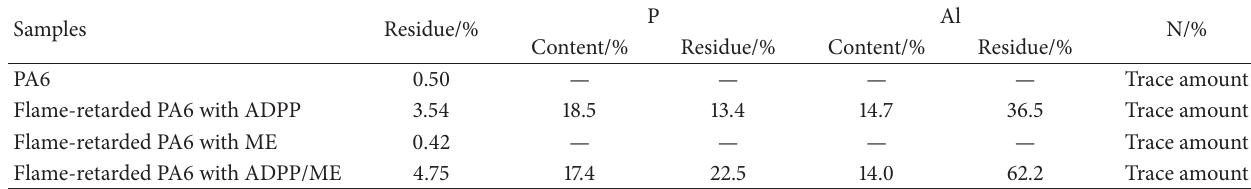
Table 4: Analysis results of the residues obtained in the cone calorimeter.